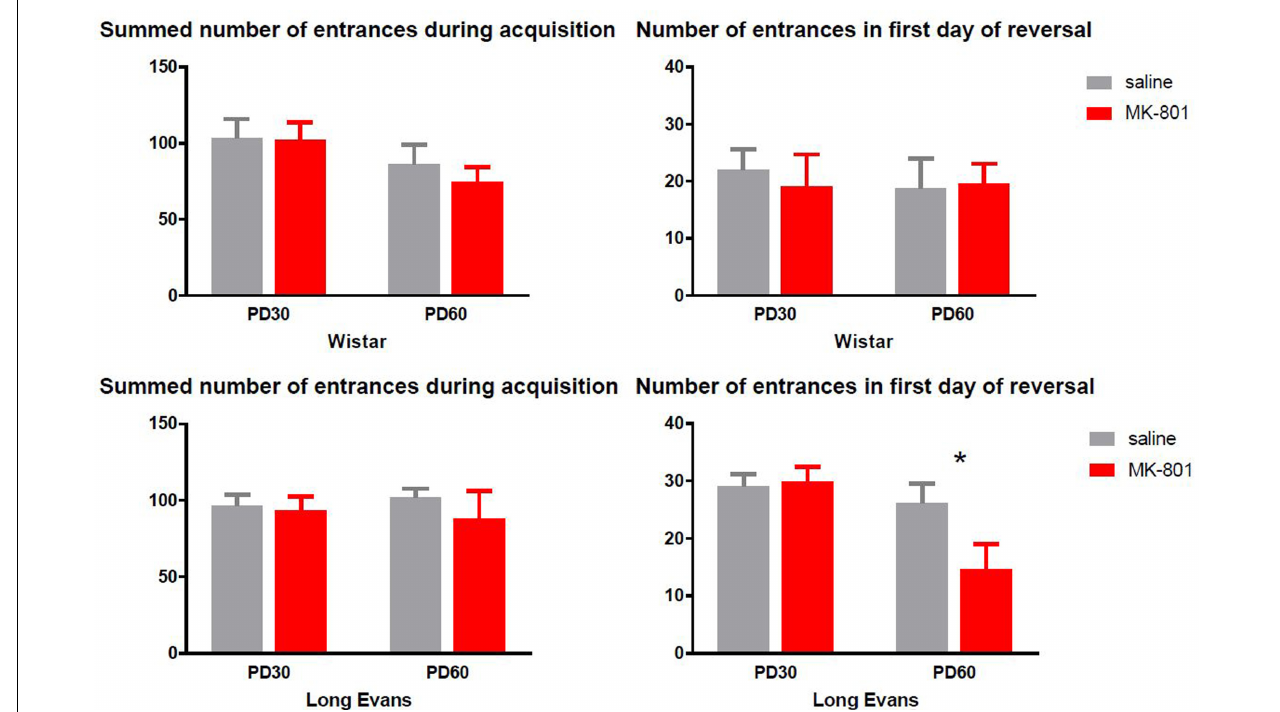
FIGURE 4 | Performance in active place avoidance evaluated as the summed number of entrances into the to-be-avoided sector during 4 days of acquisition (left graphs) and 1st day of reversal (right graphs). Differences between MK-801 and saline treated rats were statistically significant only during reversal in the Long-Evans PD 60 cohort, with MK-801 administered rats to be superior to saline controls ( ∗ P < 0.05). Group means ± SEM.